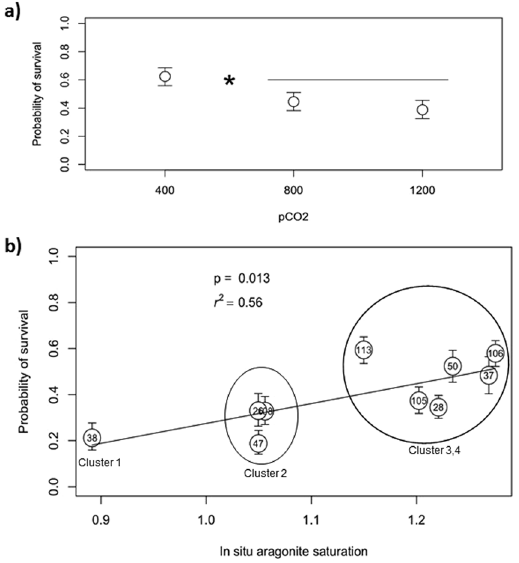
Figure 6. Probability of survival in Limacina helicina in the high CO 2 experimental setup with consideration given to underlying in situ Ω ar exposure at the collection site. ( a ) Probability of survival based on experimental pCO 2 is the highest in the lowest pCO 2 treatment regardless of the exposure history. N 400 = 187; N 800 =186; N 1200 =197. ( b ) Relationship between Ω ar at the station of collection and survival with pteropods maintained at 1200 µ atm experimental conditions. The highest survival probability was found at the sites with the most favorable conditions (shown here in Cluster Groups 3 and 4 ( Ω ar ≥ 1.2)). Survival declined under less favorable conditions (shown here in Cluster Group 2 (0.8 ≥ Ω ar ≥ 1.2) and Cluster Group 1 ( Ω ar ~ 0.89)). This linear relationship between survival probability and Ω ar is described as function = b 0 + b 1 * ( Ω ar ) = − 0.47 ( ± 0.31 s.e.) + 0.92( ± 0.27 s.e.) * Ω ar . Error bars indicate ± 1.0 standard errors. N = 570 (Supplementary Table S7). Numbers within circles identify the